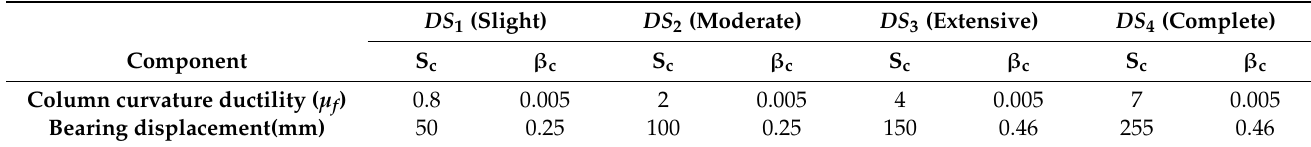
Table 3. Engineering demand parameters and damage states.